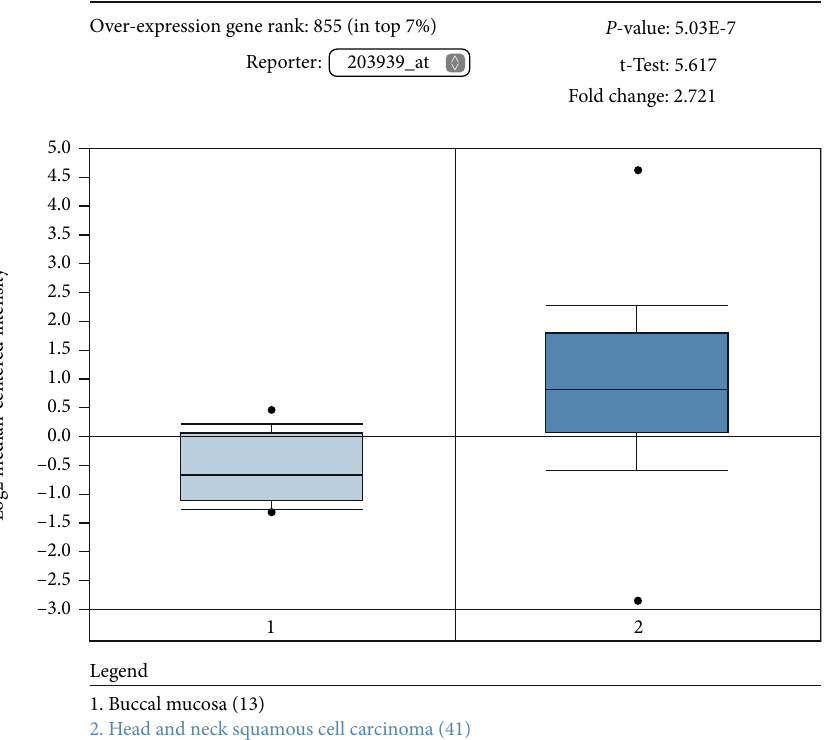
Figure 6: Validation of NT5E expression in an independent cohort. To further verify the accuracy of our results, we validated the expression of CD73 in an independent cohort. We used the “ Ginos Head-Neck ” cohort in the Oncomine database to analyse, which is independent for the TCGA cohort. The results showed that CD73 was highly expressed in HNSCC compared with normal tissues ( P = 5 : 03E − 7